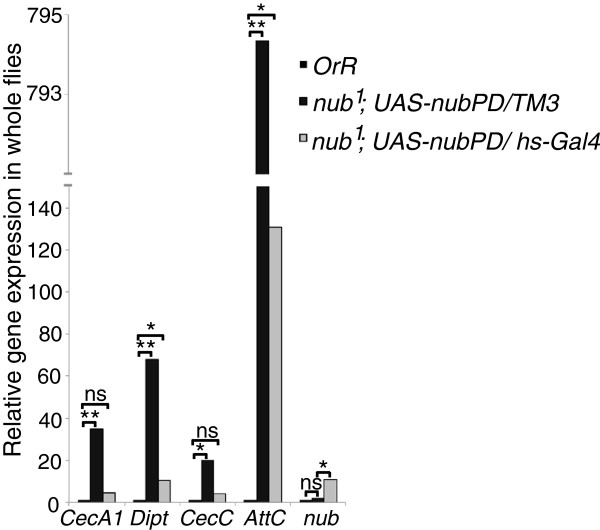
Expression of Nub-PD from a transgene restores normal regulation of antimicrobial peptide genes in a nub1 mutant background. Quantification of CecA1, Dipt, CecC, AttC and nub-RD mRNA by RT-qPCR in extracts of uninfected whole flies. Expression was measured in wild type (OrR; black bars), nub1 flies (nub1/nub1; UAS-nub-RD/+; dark gray bars) and nub1 flies expressing a nub-RD transgene (nub1/nub1;UAS-nub-RD/hs-Gal4; light gray bars). The data are mean values; n = 3. Statistical significance was calculated using paired t-test, *P <0.05, **P <0.01.